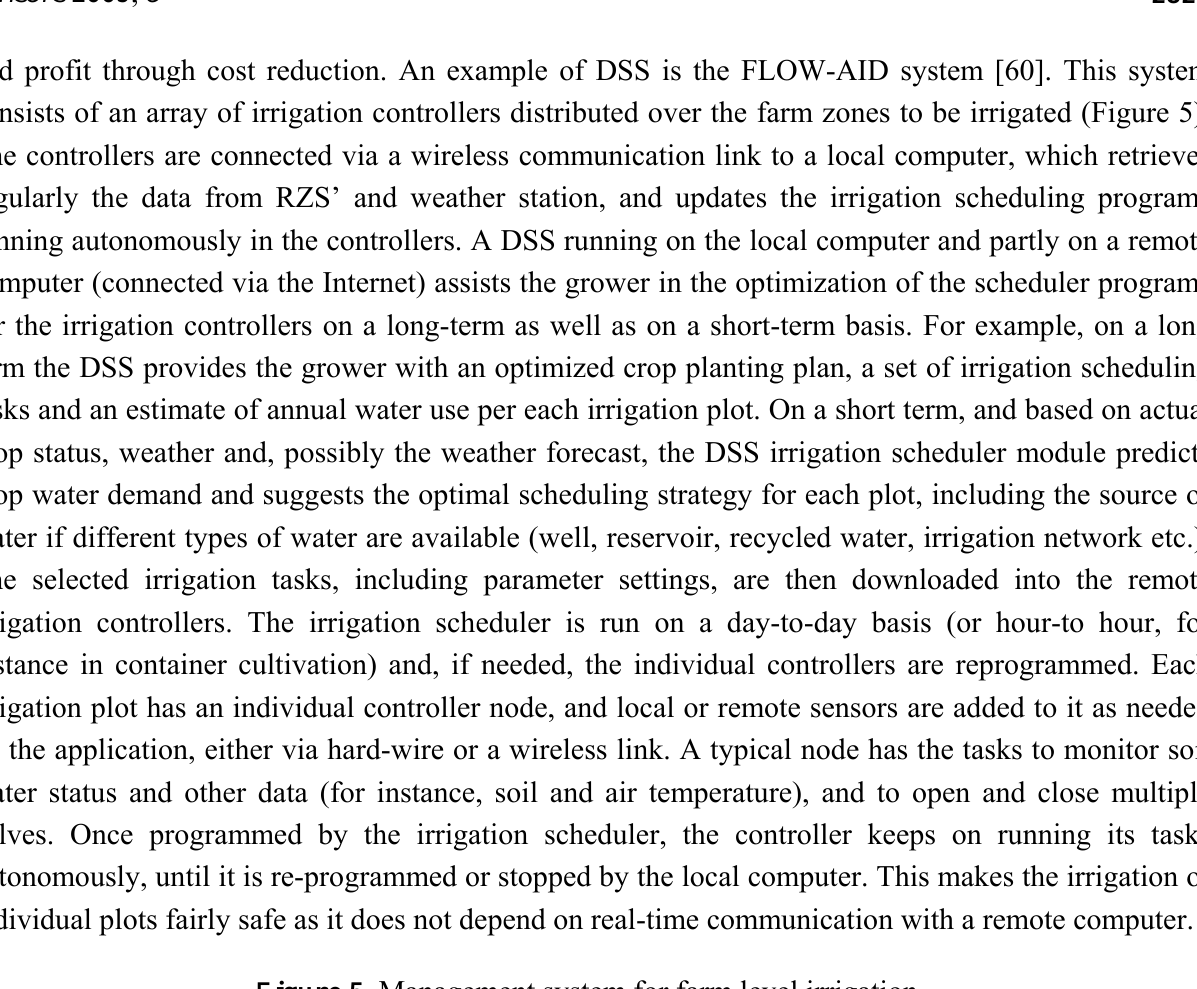
Figure 5. Management system for farm level